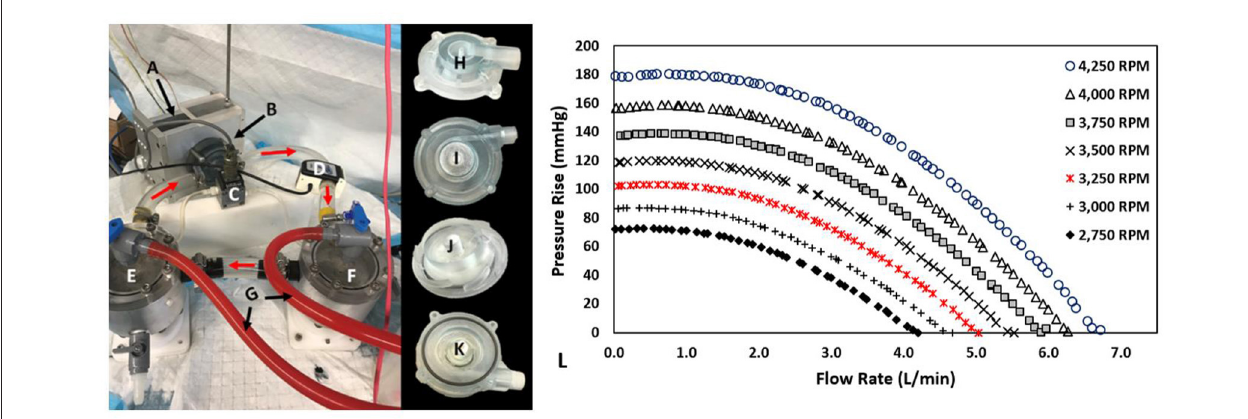
FIGURE 6 | Hydraulic Test Rig, Centrifugal Prototype, and Performance Results: (A) Magnetically Levitated Drive System, (B) centrifugal blood pump, (C) Validyne differential pressure transducer, (D) Transonic Ultrasonic flow probe, (E) Inlet tank, (F) Outlet tank, (G) Air bleed hoses, (H) Inlet volute, (I) Outlet volute, (J) Impeller, (K) Partially assembled prototype, (L) Prototype Performance Results: 0-6.7 L/min at 0.5-180.3 mmHg for 2,750-4,250 RPM.